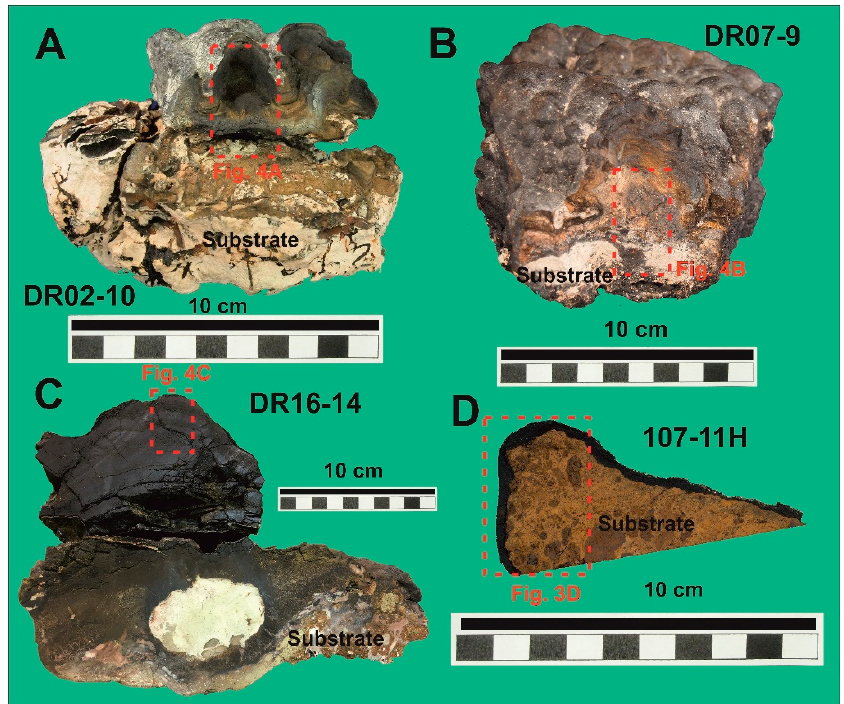
Figure 2. Image of selected Fe-Mn crust samples for this study. ( A ) Crust DR02-10 was dredged from Echo Sm., ( B ) crust DR07-9 from The Paps Sm., ( C ) DR16-14 and ( D ) 107-11H from Tropic Sm. Red